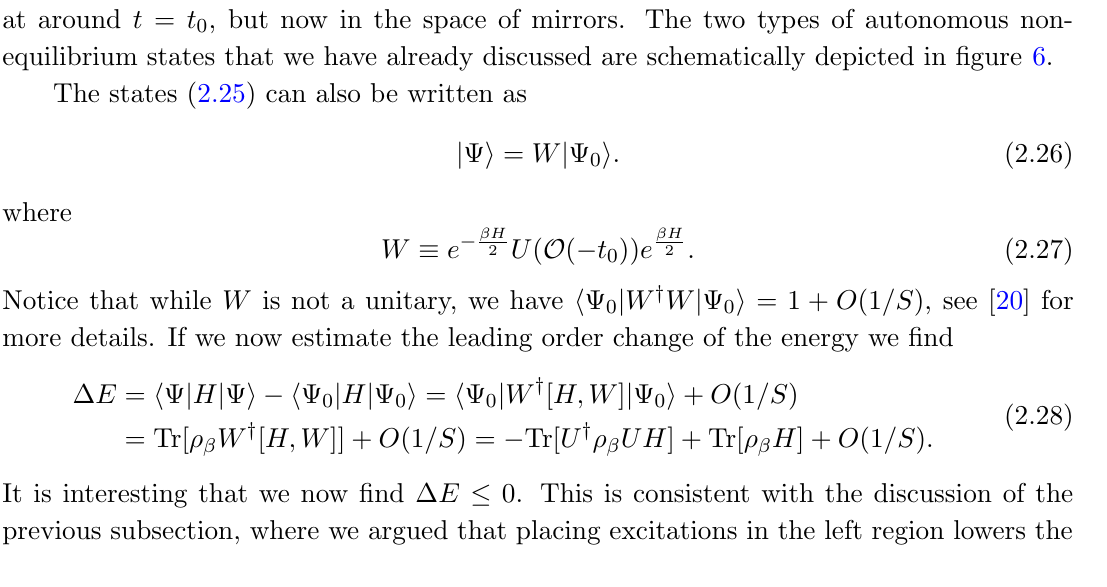
the state looks 0 an excitation seems to be emitted from the 0 i 0